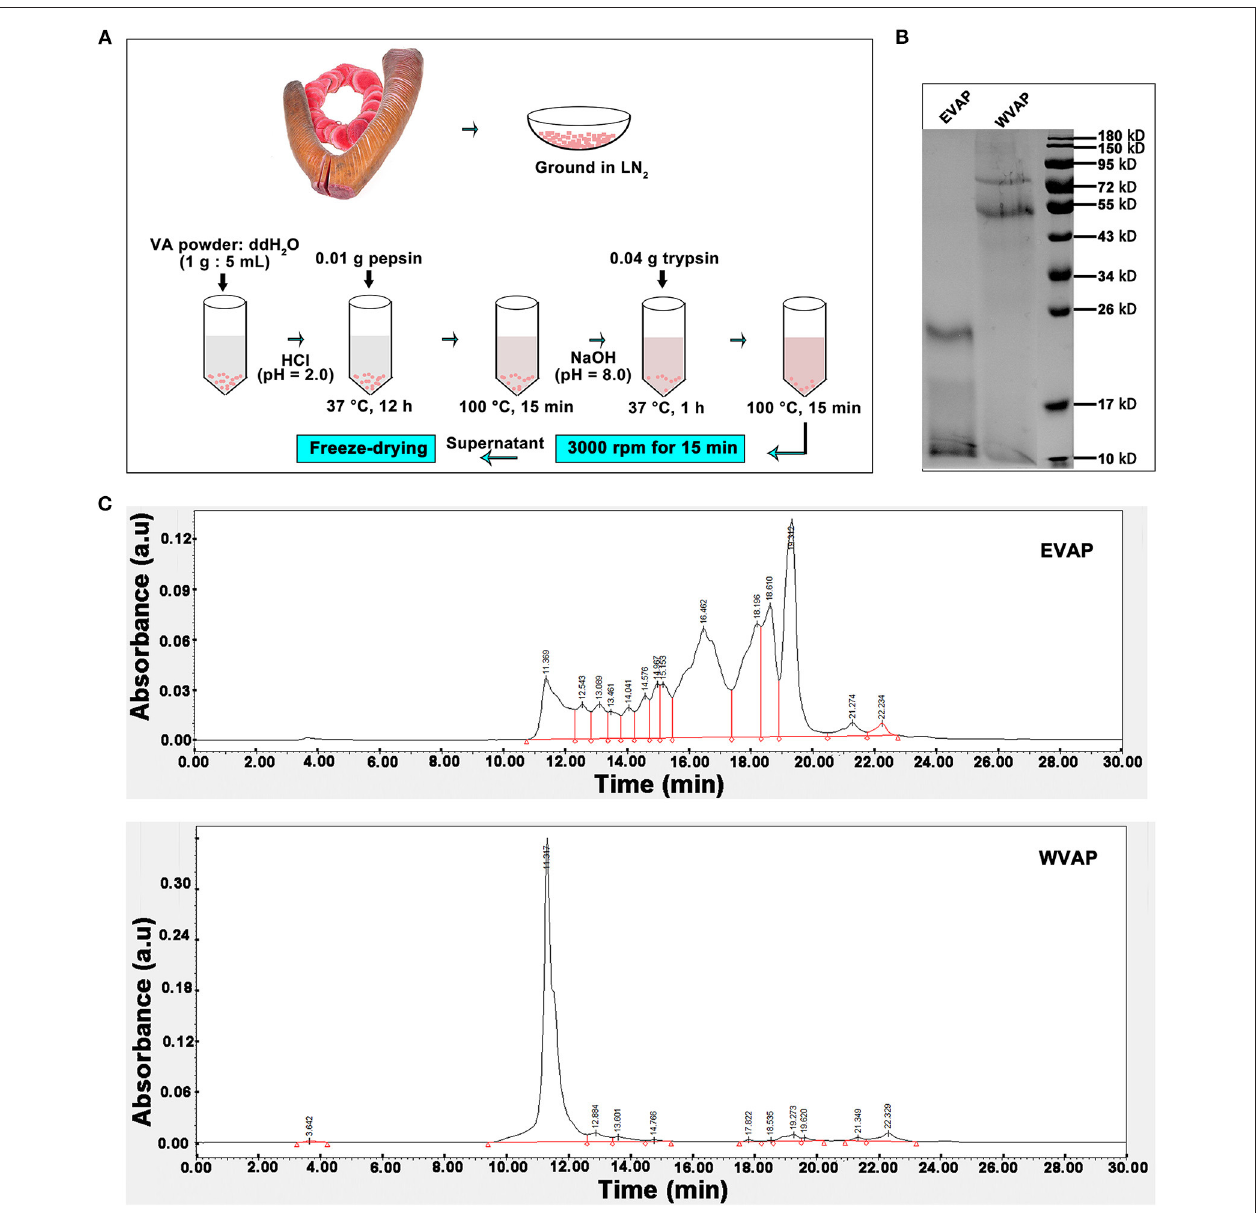
FIGURE 1 | Preparation and characterization of EVAP. (A) Schematic drawing of EVAP preparation procedure. (B) SDS-PAGE electrophoresis of EVAP and WVAP. Note that molecular weight of the EVAP lies between 10 and 26 kD. (C) Profiling of EVAP and WVAP through HPLC. Note that compared to WVAP, the profiling of EVAP had shifted toward the lower molecular end and consisted of 14 peaks. EVAP, enzymatically-digested velvet antler peptides; HPLC, high performance liquid chromatography; LN2, liquid nitrogen; SDS-PAGE, sodium dodecyl sulfate-polyacrylamide gel electrophoresis; VA, velvet antler; WVAP, water velvet antler peptides.